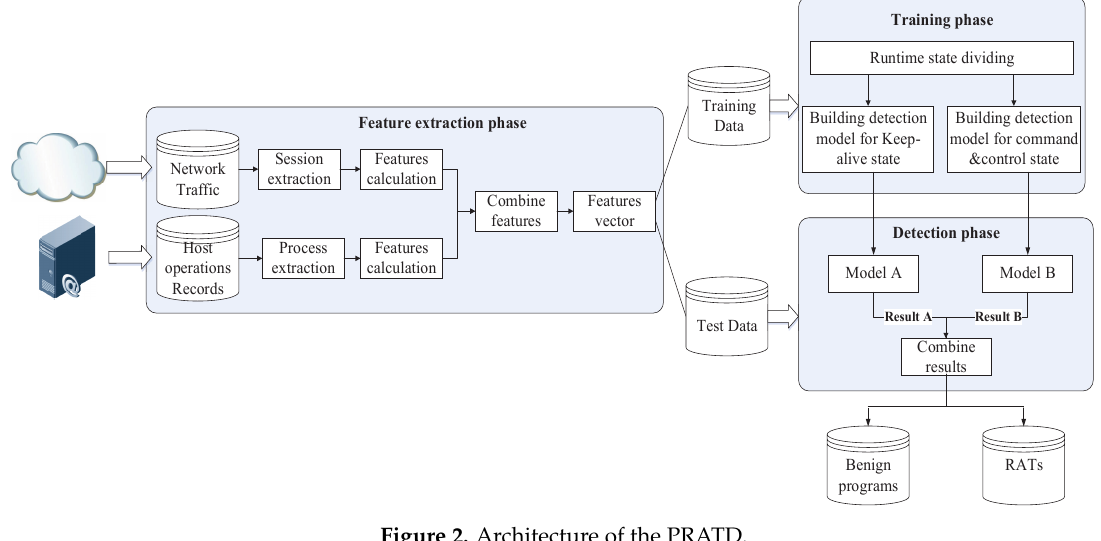
Figure 2. Architecture of the